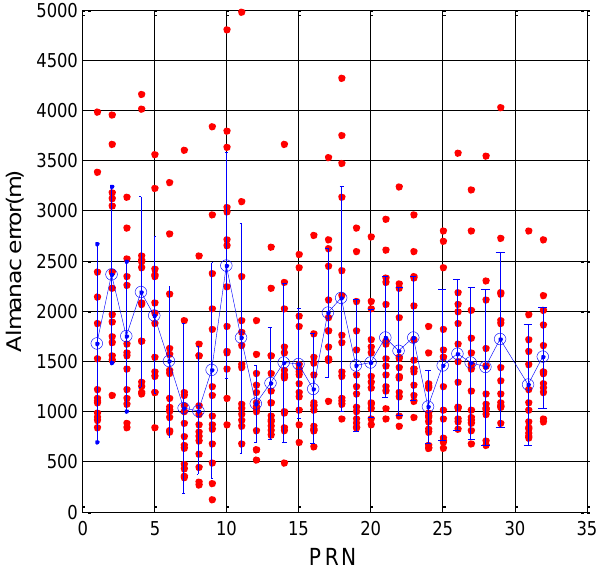
Figure 14. GPS DQA4: Satellite Position Difference between Almanac and